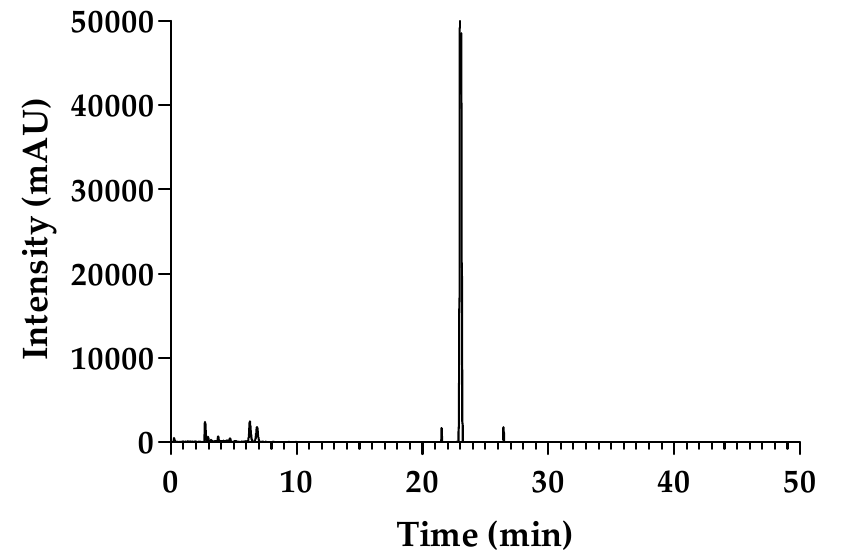
Figure 1. sPLA2 purity profile by high-performance liquid chromatography (HPLC). The enzyme purification was performed with a TSKgel SP-5PW (7.5 cm ID × 7.5 cm · L) using a non-linear gradient with buffer B (ammonium bicarbonate 1.0 M) at a constant flow rate of 1.0 mL/min. The active sPLA2 underwent a new chromatographic step on a reverse phase HPLC using a C5 semi-analytical column. In this step, the chromatographic column was pre-equilibrated with buffer A (0.1% TFA) for 30 min at a flow rate of 1 mL/min. Samples of sPLA2 (1 mg) were dissolved in 250 µ L of buffer A and separated using the chromatographic column. Elution of the sPLA2 was performed with a continuous linear gradient of buffer B (66% acetonitrile in 0.1% TFA), and the monitoring of the chromatographic profile was at 280 nm.